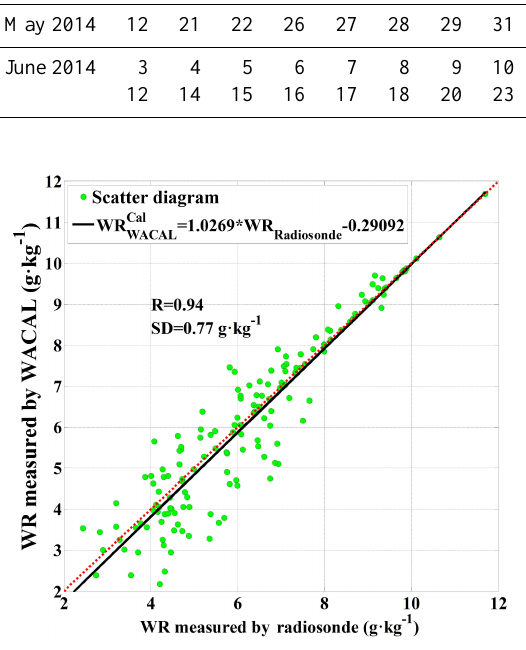
Figure 3. Validation of the calibrated water vapor mixing ratio (red dashed line is 1:1 curve and black line is fitting